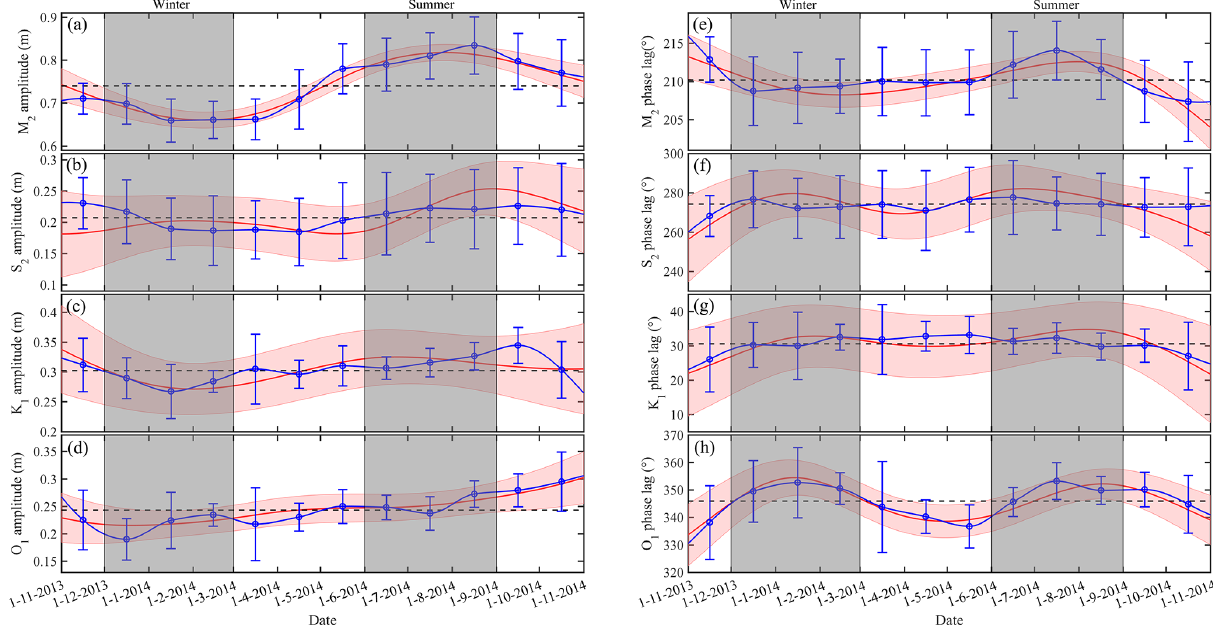
Figure 4. Time series of the temporally varying tidal amplitudes of principal tidal constituents (a) M 2 , (b) S 2 , (c) K 1 , and (d) O 1 at E2 estimated with CHA (black dashed lines), SHA (blue lines), and EHA (red lines). Panels (e) – (h) similar to (a) – (d) but for the estimated temporally varying tidal phase lags. Blue vertical bars and pink shading indicate the corresponding 95% confidence